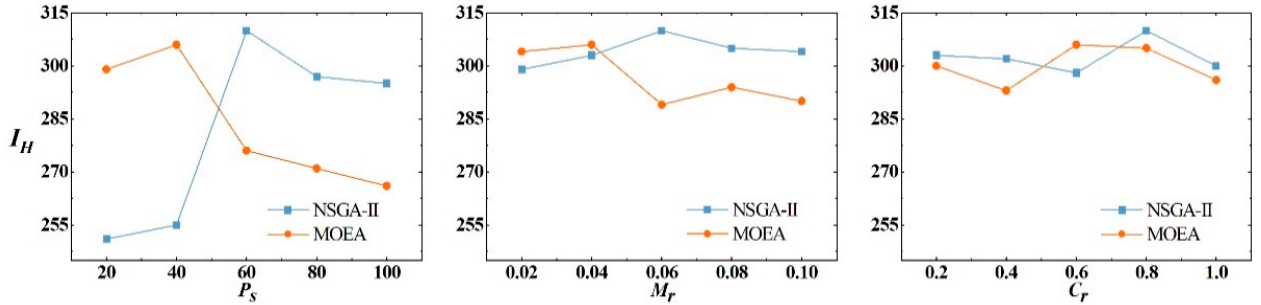
Figure 3. The influence of changing the metaparameters on I H .